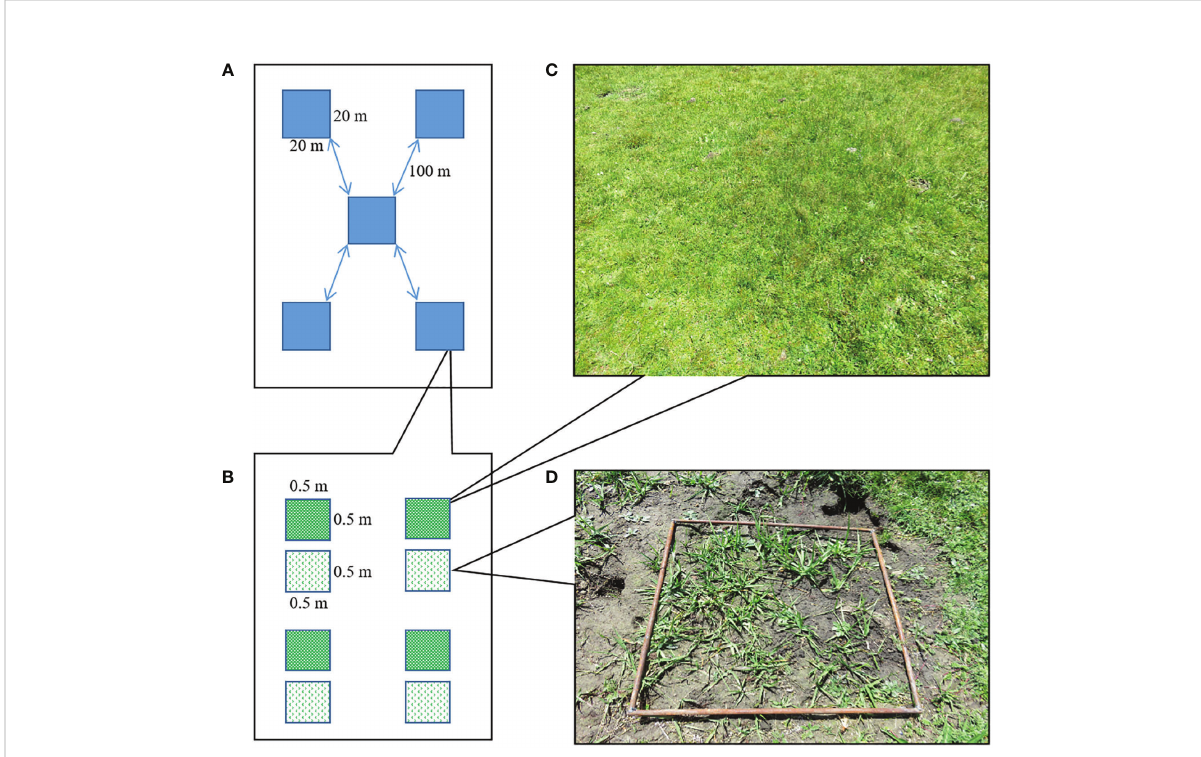
FIGURE 1 Study design. (A) Five sites were selected, (B) each site had two types of plots, (C) a control plot, (D) and a bare patch plot created by plateau pika burrowing